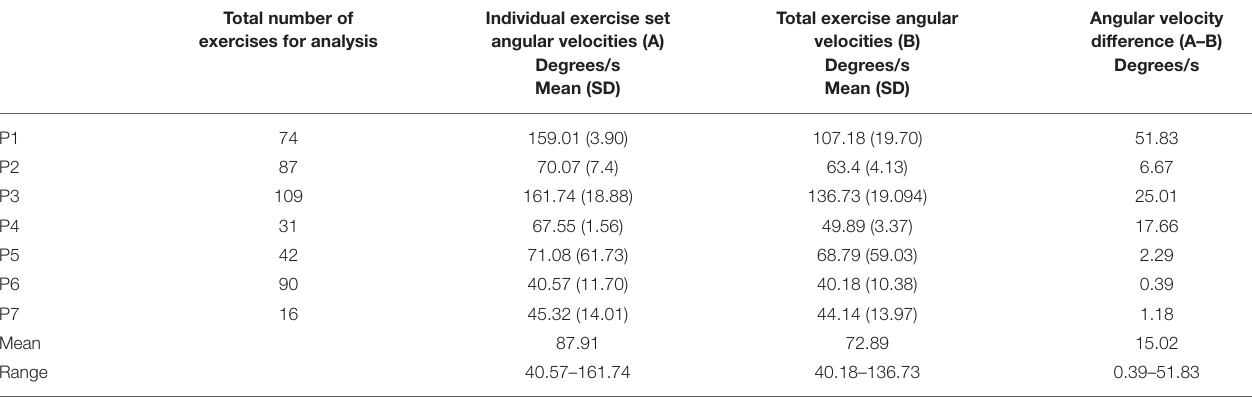
TABLE 3 | Comparison of individual exercise set and total exercise total average angular velocity (degrees/s) across all exercises. Total number of exercises for